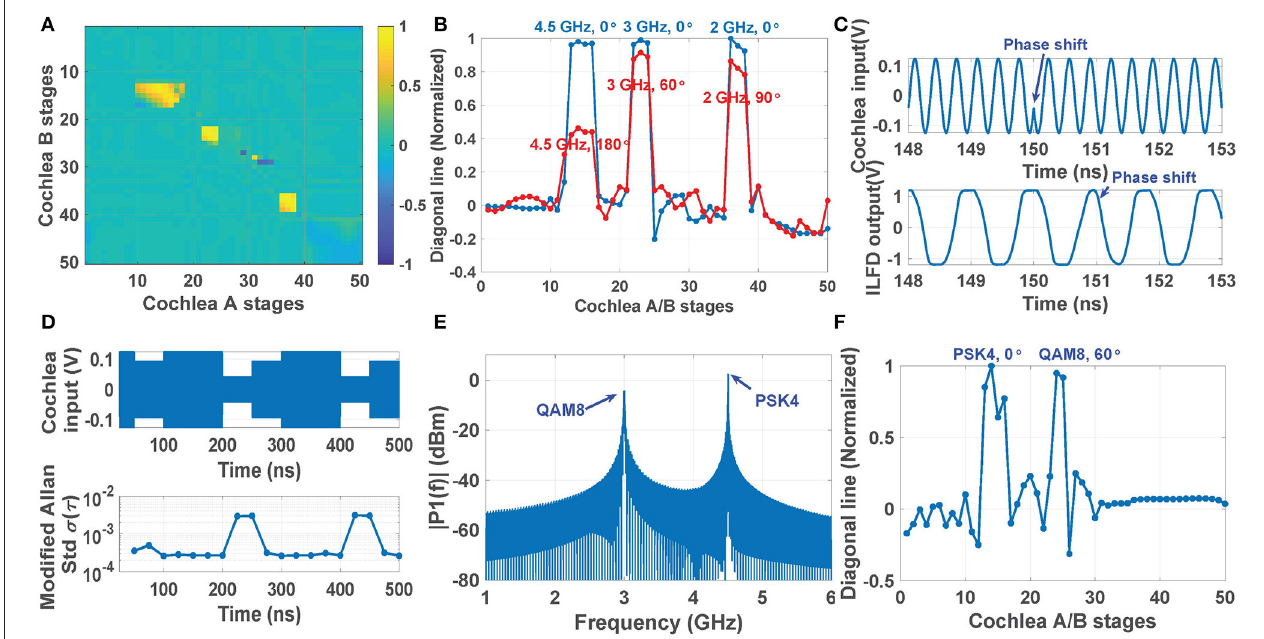
FIGURE 8 | Simulation results showing the ILFD-based cross-correlogram generated by a three-tone input: (A) 4.5, 3, and 2 GHz with all ITDs equal to 0; (B) the corresponding normalized diagonal line (blue line), compared with the diagonal line with non-zero ITDs, namely [ π , π/ 3, π/ 2] (red line). (C) Time domain waveforms of a QAM8-modulated cochlea input and the resulting ILFD output during a symbol transition. (D) Modified Allen deviation of a single stage output (for averaging time τ = 5.12 ns) estimated each 25 ns when the cochlea receives a QAM16 input with a symbol rate of 20 MS/s; (E) Measured power spectrum of an input signal consisting of two modulation types (PSK4 and QAM8), and (F) its ILFD-based cross-correlogram.